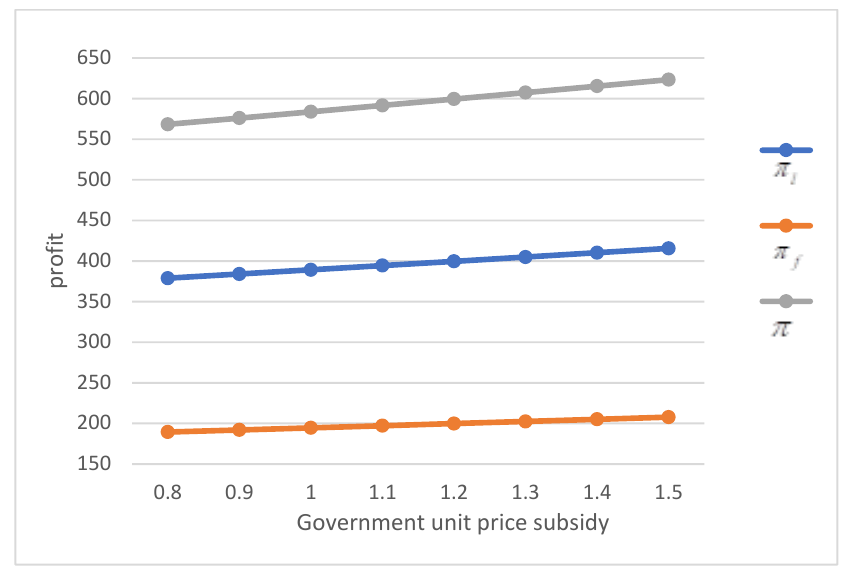
Figure 1. Sensitivity analysis of government unit price subsidy. Table 9. Sensitivity analysis of government unit price subsidy.